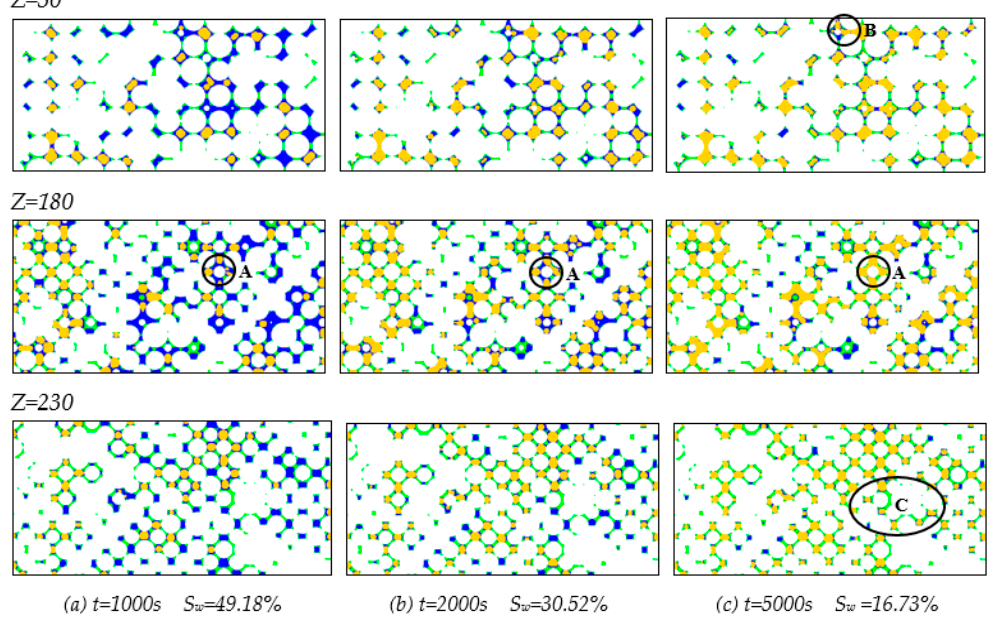
Figure 15. Distribution of gas and water on different cross sections of core 24 # under high temperature and pressure conditions.